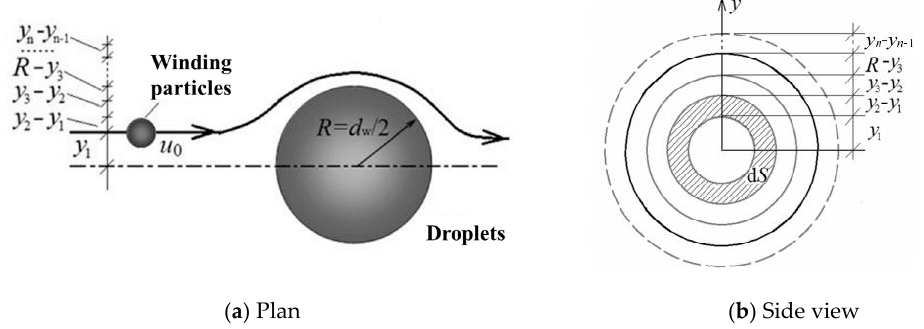
Figure 3. Schematic diagram of turbulence fitting efficiency [44].